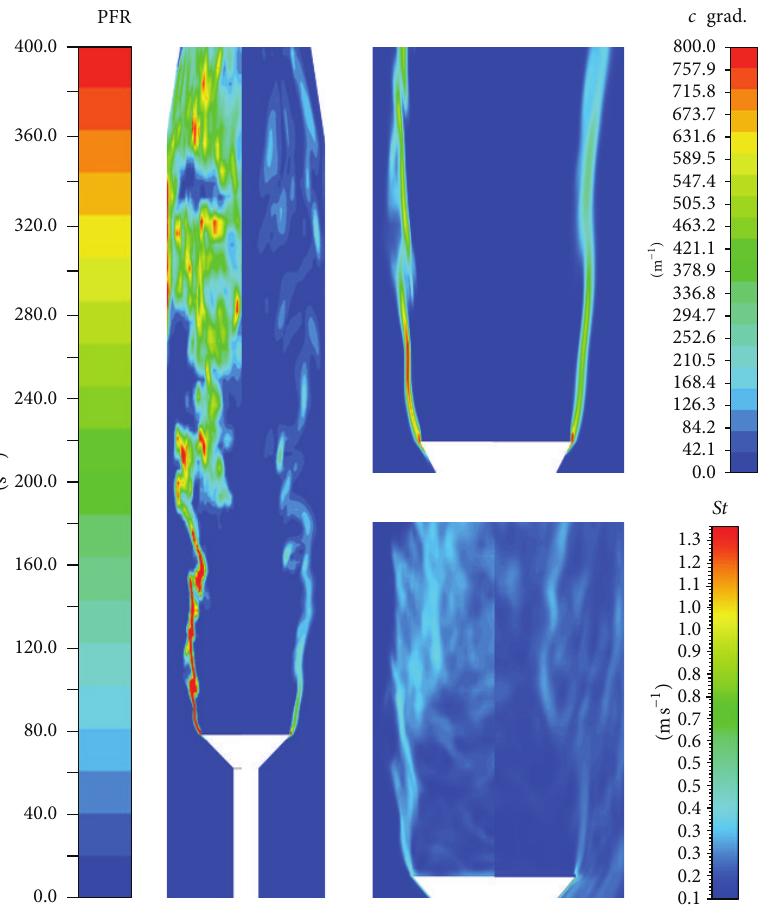
Figure 19: Product formation rate, turbulent flame speed, and progress variable gradient